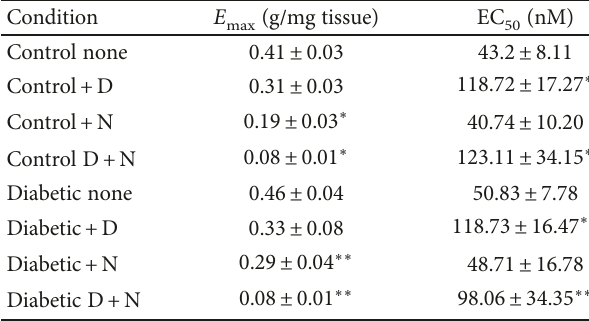
Table 3: E ff ects of a 30min incubation period with 50 μ M dantrolene (D), 50nM nimodipine (N), and both drugs in combination (D +N) on EC and E values for PHE-induced 50 max contraction in control and diabetic